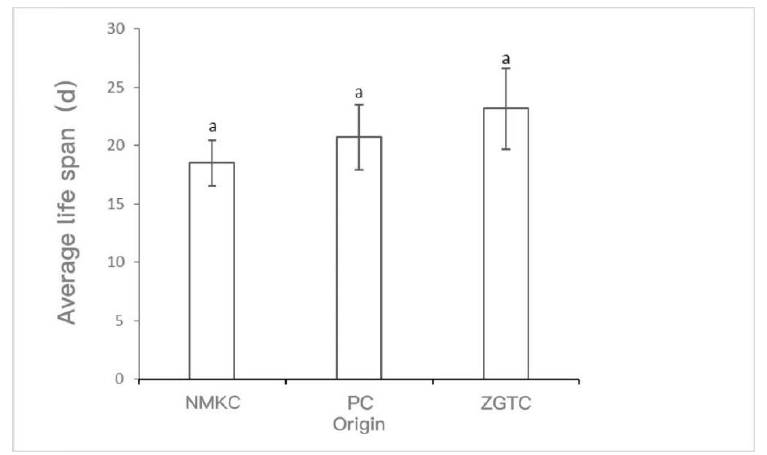
Figure 3. Life span of Daphniopsis tibetana from different origins. Means with different lowercase letters are significantly different ( p < 0.05). a: no significant difference